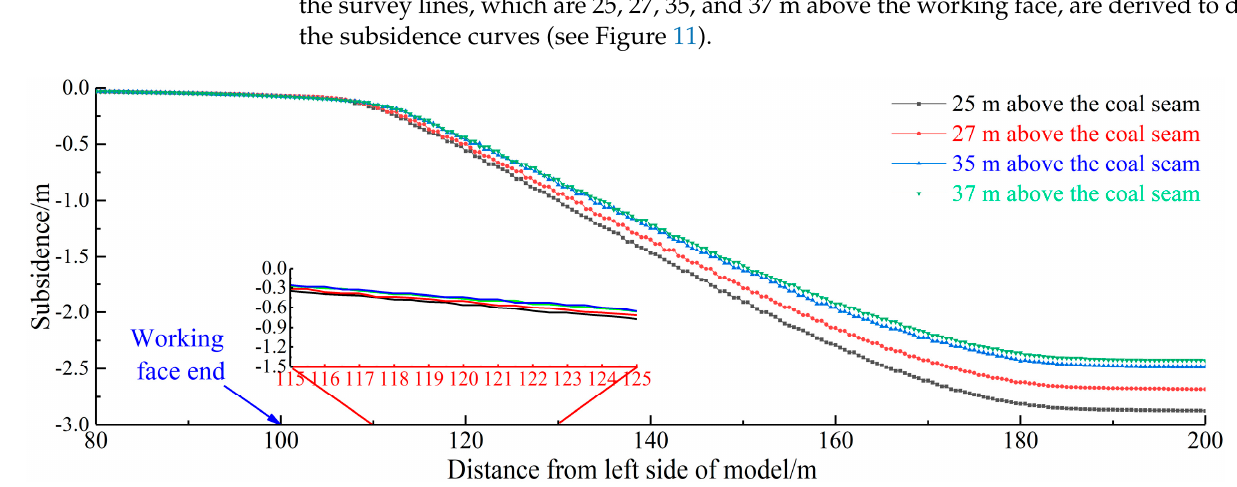
Figure 11. Subsidence